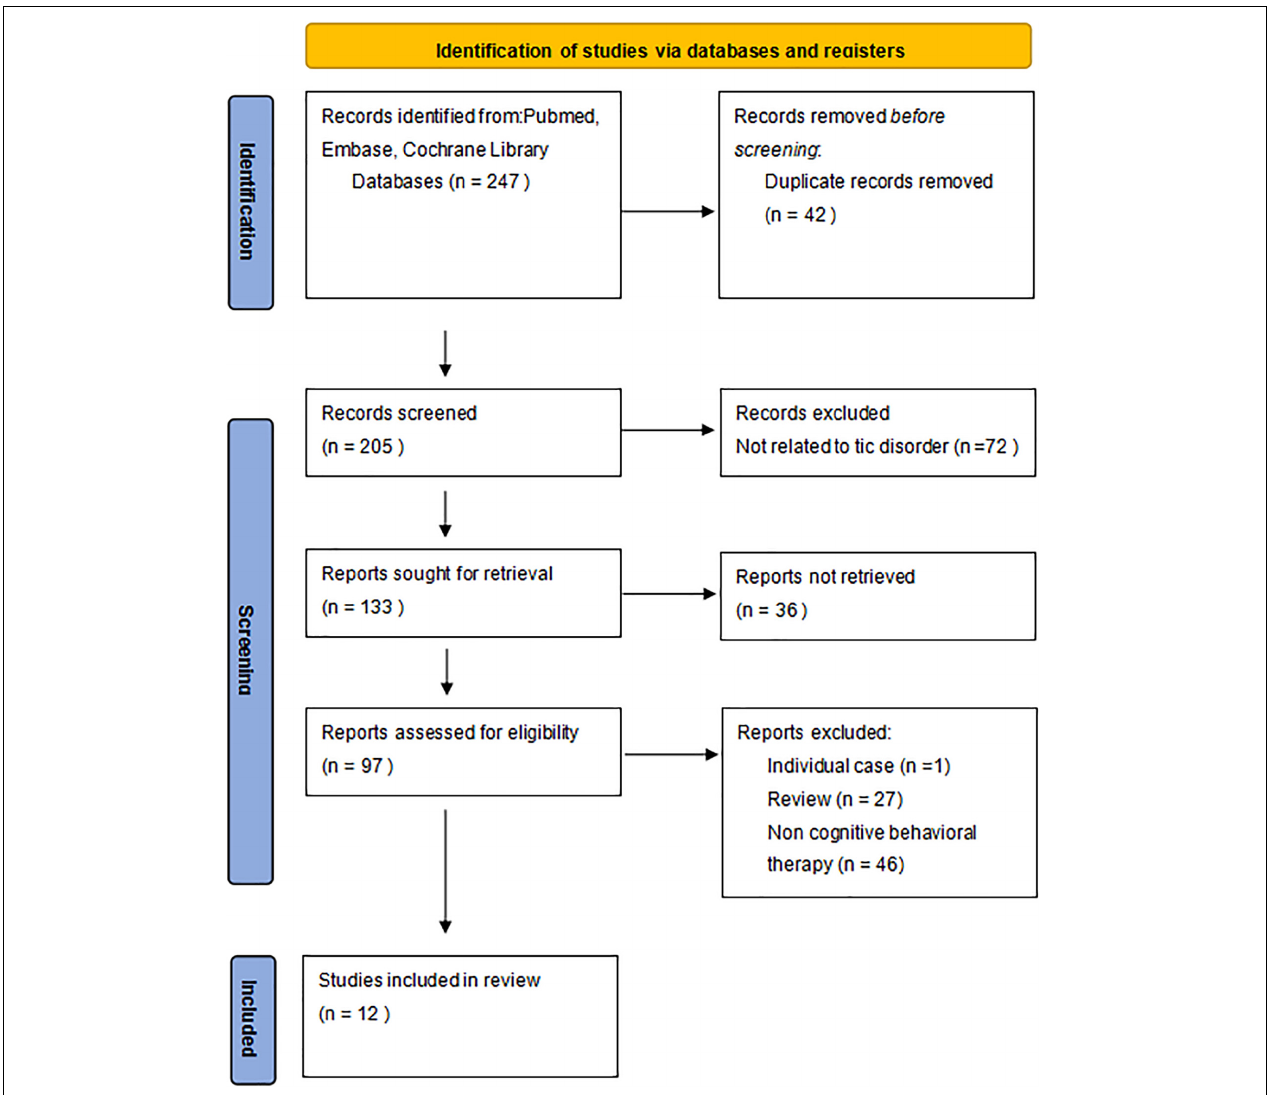
FIGURE 1 | The Preferred Reporting Items for Systematic Reviews and Meta-Analyses (PRISMA) flowchart of study identification, screening, assessment of eligibility, and inclusion for